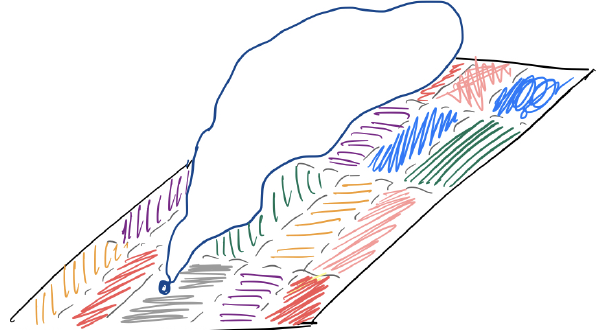
Figure 4. A schematic showing the setup for a methane plume over different surface tiles, each of which contains one surface albedo from our